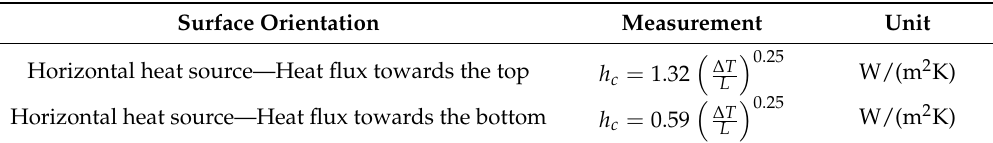
Table 1. Heat transfer coefficients for free convection on horizontal flat surfaces— ∆ T is the difference between surface and ambient temperatures— L is a characteristic dimension of the surface